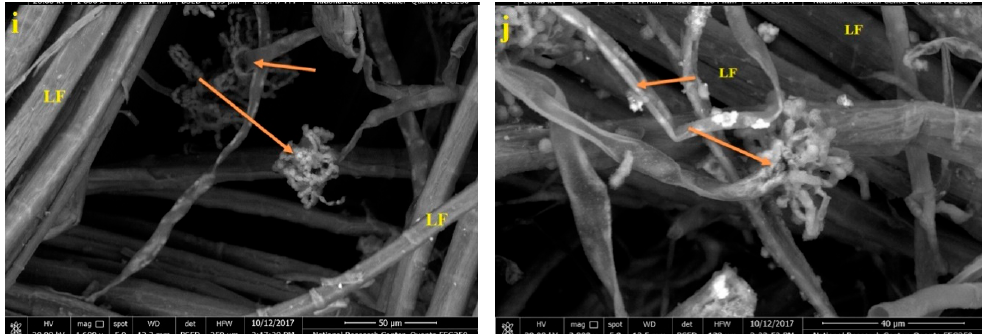
Figure 5. SEM images of the linen fibers treated with V. agnus-castus leaf oil ( a – d ); linen fibers colonized with A. flavus ( e , f ), C. cladosporioides ( g , h ), and P. chrysogenum ( i , j ). LF: Linen fiber; arrows refer to the growth of the fungi hayphae.